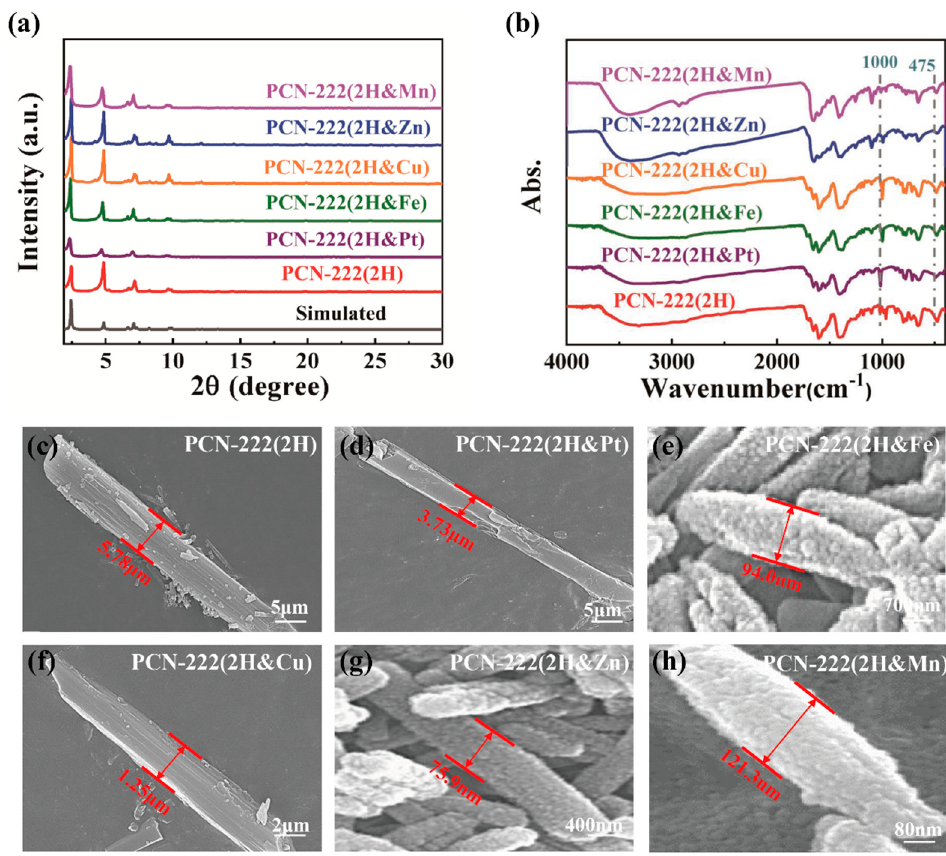
Figure 1. ( a ) PXRD patterns, ( b ) FT-IR spectra of all materials, and ( c – h ) scanning electron microscopy (SEM) images of ( c ) PCN-222(2H), ( d ) PCN-222(2H&Pt), ( e ) PCN-222(2H&Fe), ( f ) PCN-222(2H&Cu), ( g ) PCN-222(2H&Zn), and ( h )